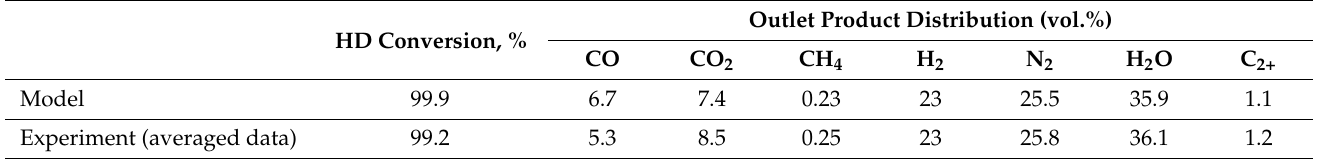
Table 4. The outlet product distributions in the model and experimental ATP processes [95]. Outlet Product Distribution (vol.%) HD Conversion, % CO CO 2 Model 99.9 Experiment (averaged